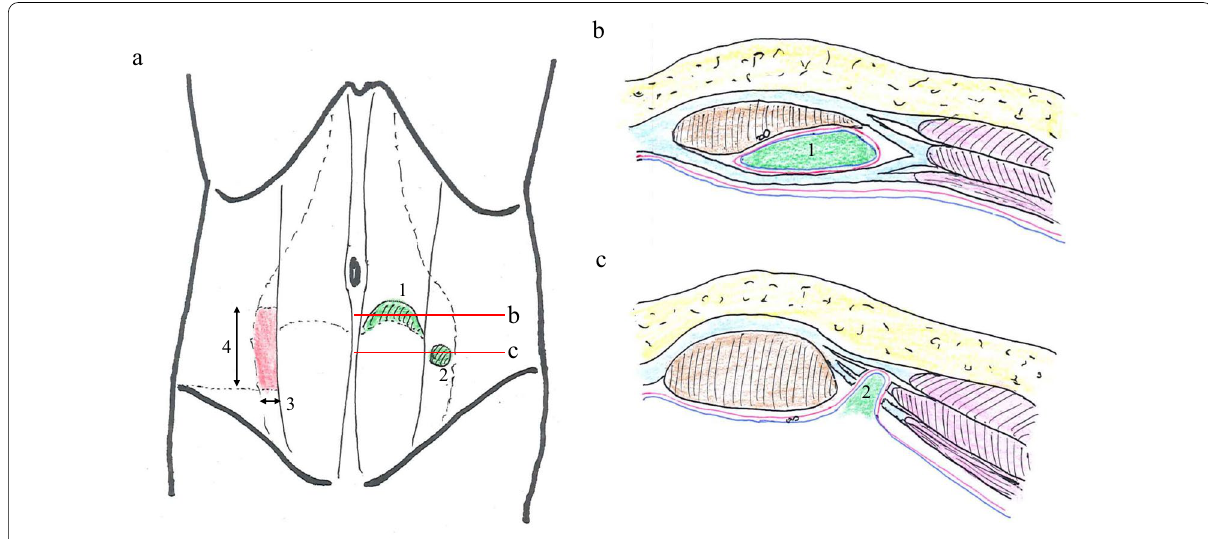
Fig. 4 Anatomical location of arcuate line hernia ( 1 ) and Spigelian hernia ( 2 ). ( 3 ) Spigelian aponeurosis, between the semilunar line (muscular– aponeurosis transition of the transverse abdominis muscle) and the lateral edge of the rectus abdominis. ( 4 ) Spigelian hernia